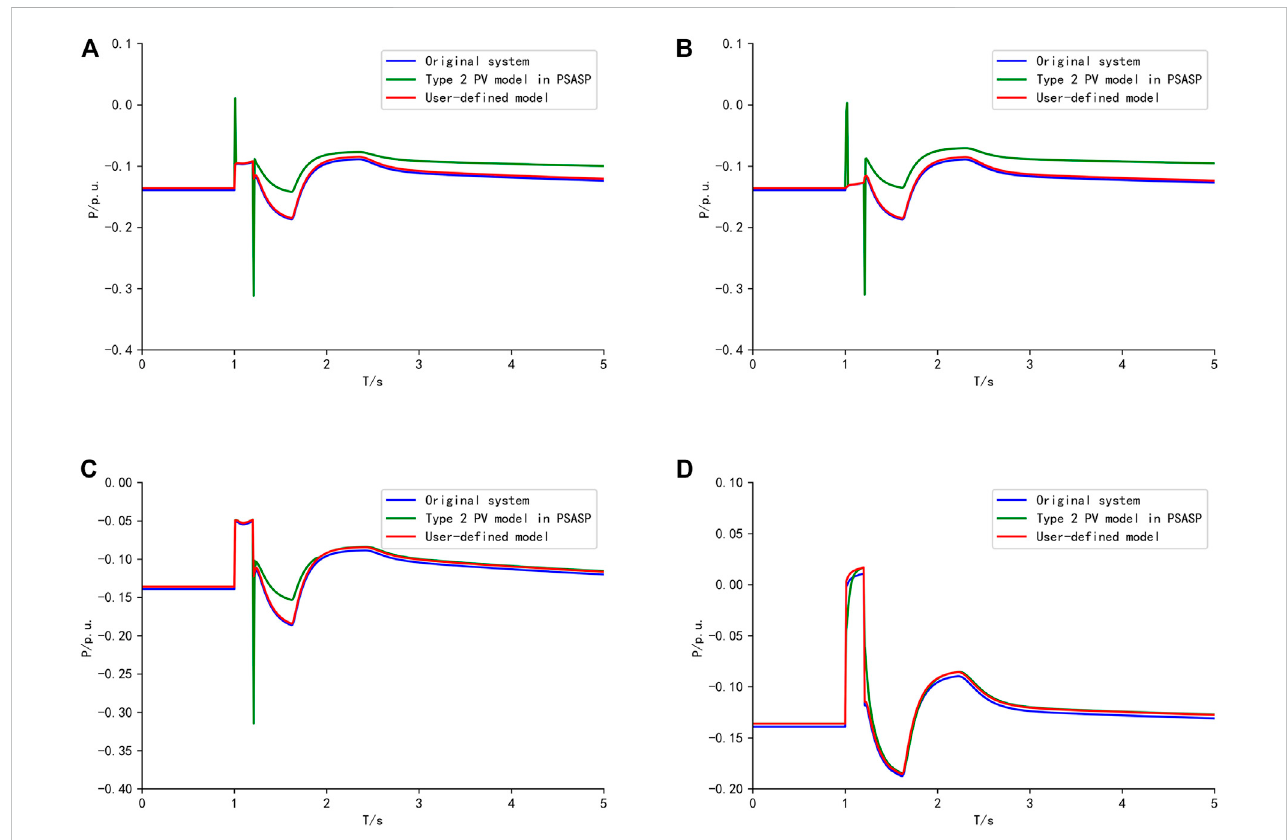
FIGURE 9 Comparison of active power response of condition 3. (A) Fault 1, (B) Fault 2, (C) Fault 3, (D) Fault 4.